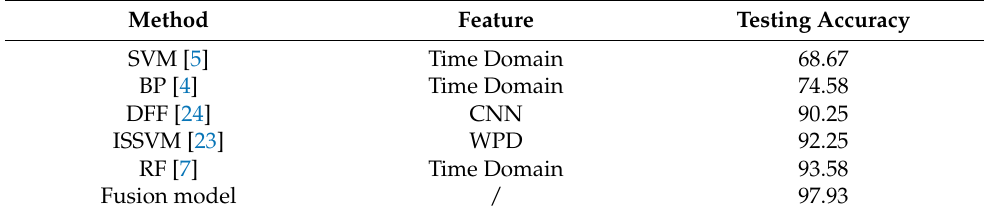
Table 5. The accuracy (%) table comparison with other